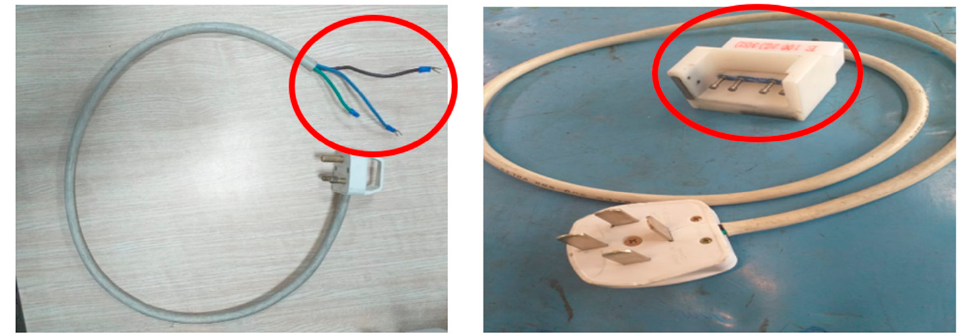
Figure 9. Old and new power cord.